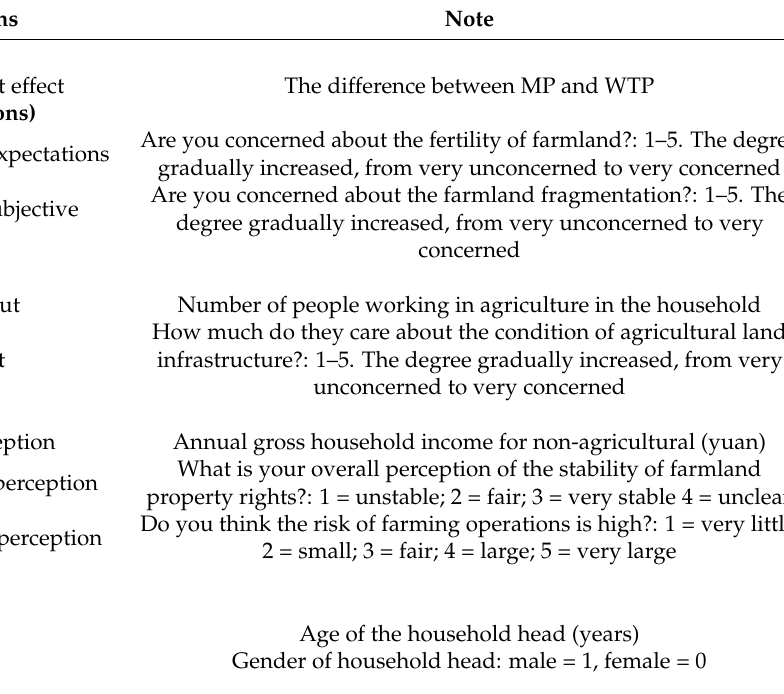
Table 2. Variable setting of the demand-side endowment